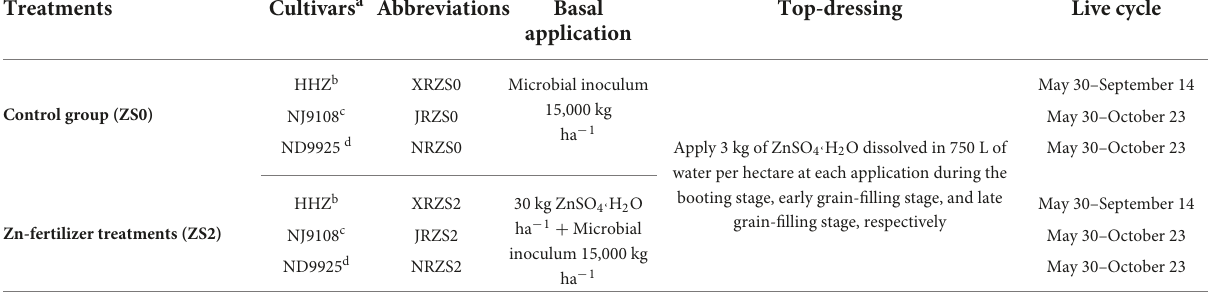
TABLE 1 Treatments, abbreviations, and fertilization status. Treatments